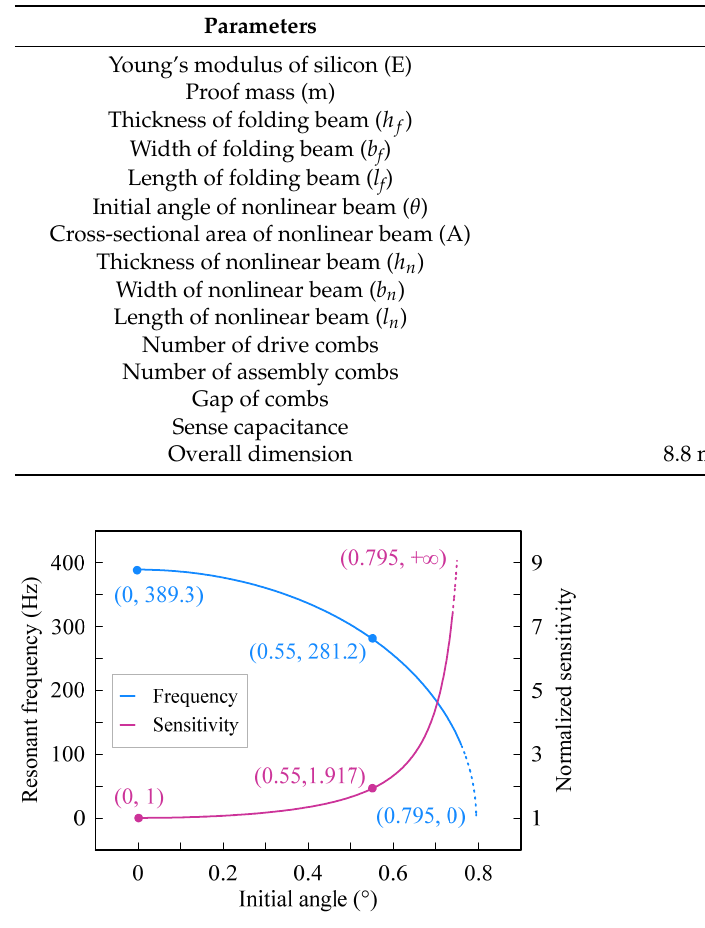
Figure 3. Variation of resonant frequency and sensitivity as initial angle changes.